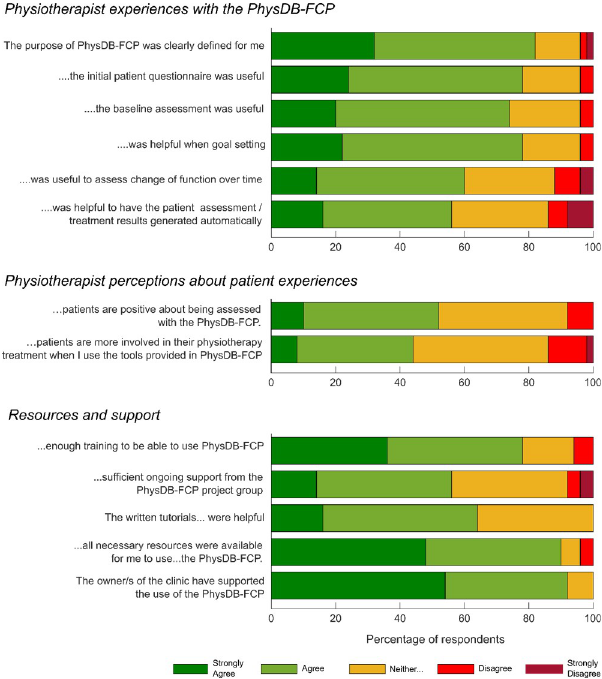
Fig 1. Therapist responses for all Likert scale questions. Included are responses that dealt with the Physiotherapist experiences with the PhysDB-FCP-FCP, responses that dealt with the physiotherapist perceptions of patient experiences when using the PhysDB-FCP-FCP and responses that dealt with resources and support. Reponses categories were: strongly agree (dark green), agree (light green), neither agree nor disagree (yellow), disagree (red), strongly disagree (dark